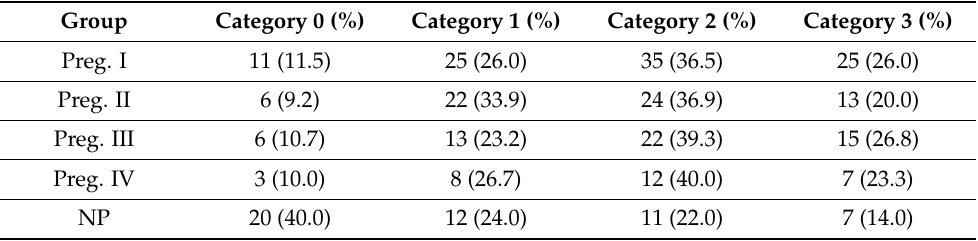
Table 4. Streptococcus mutans ( SM ) counts in the saliva of pregnant women at different gestational ages compared with non-pregnant women.